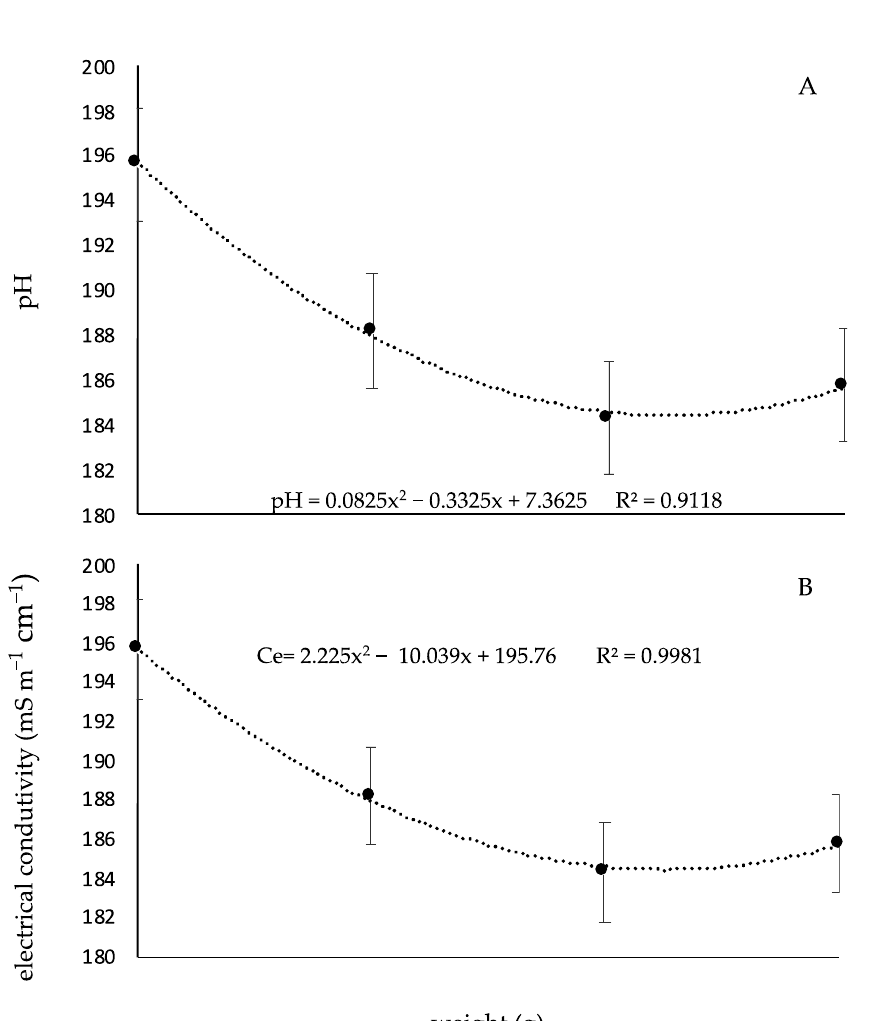
Figure 3. Water pH/[H + ] ( A ) and electrical conductivity ( B ) treated with Nopalea cochenillifera biomass.